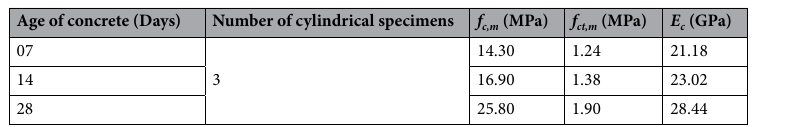
Table 3. Results for characterization of concrete (avg. values).